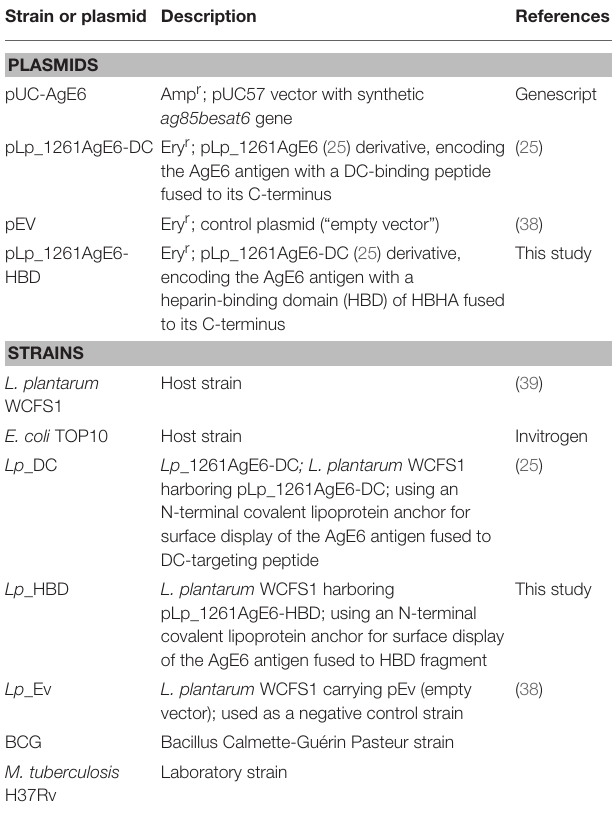
TABLE 1 | Plasmids and strains used in this